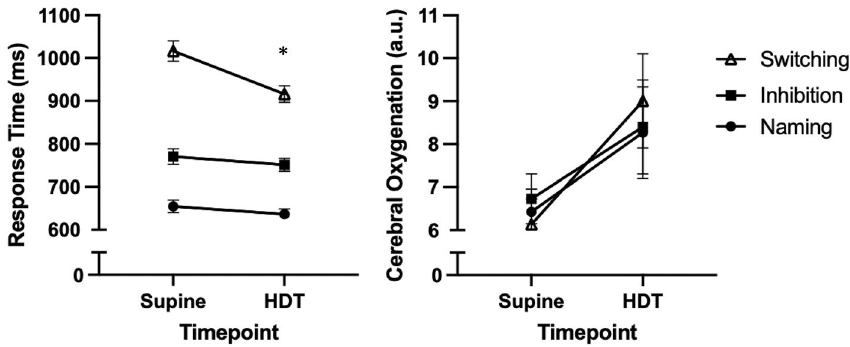
Figure 4. Response time and cerebral oxygenation levels in three Stroop task pre and at end of head down tilt. Error bars are standard error of the mean. *Different from Supine Switching, p < 0.05. a.u arbitrary units;